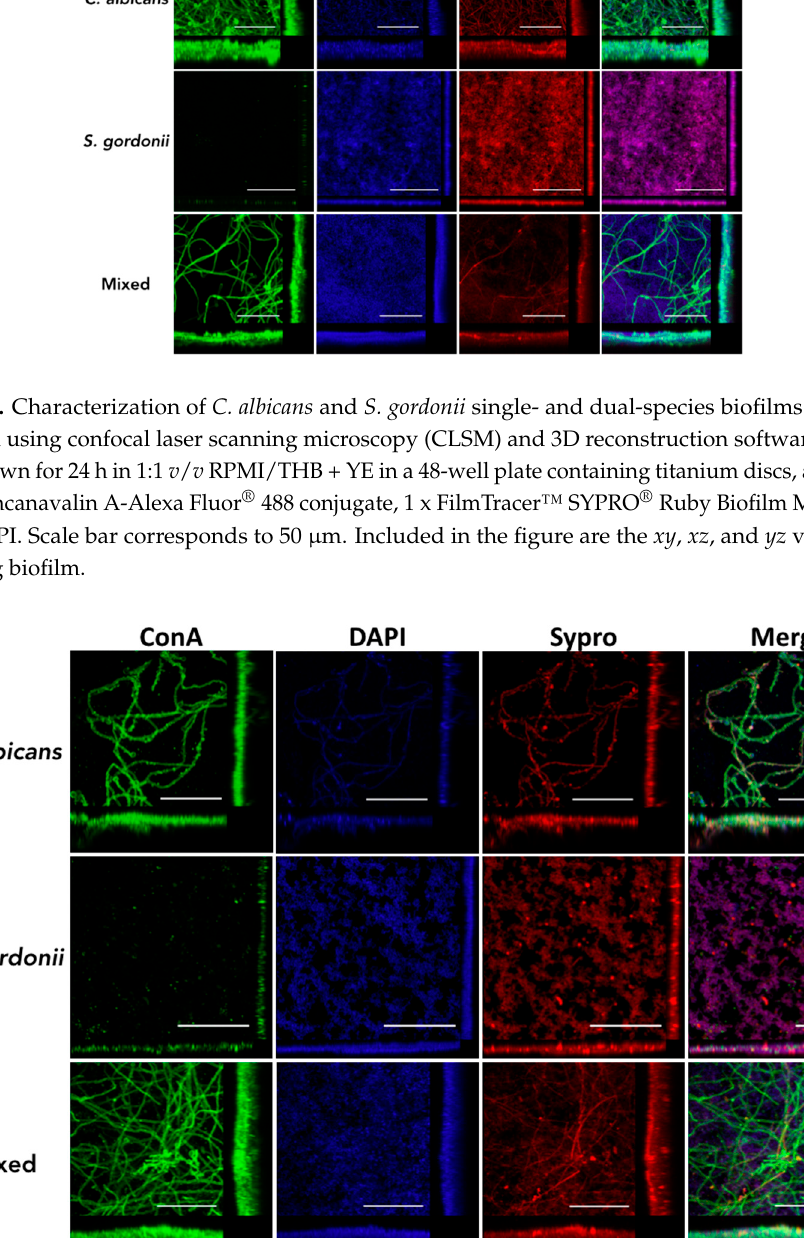
Figure 4. Characterization of C. albicans and S. gordonii single- and dual-species biofilms formed on titanium using CSLM and 3D reconstruction software. Biofilms were grown for 24 h in BMM synthetic saliva in a 48-well plate containing titanium discs, and stained with Concanavalin A-Alexa Fluor ® 488 conjugate, 1 x FilmTracer™ SYPRO ® Ruby Biofilm Matrix Stain, and DAPI. Scale bar corresponds to 50 µm. Included in the figure are the xy , xz , and yz views of the resulting biofilm.